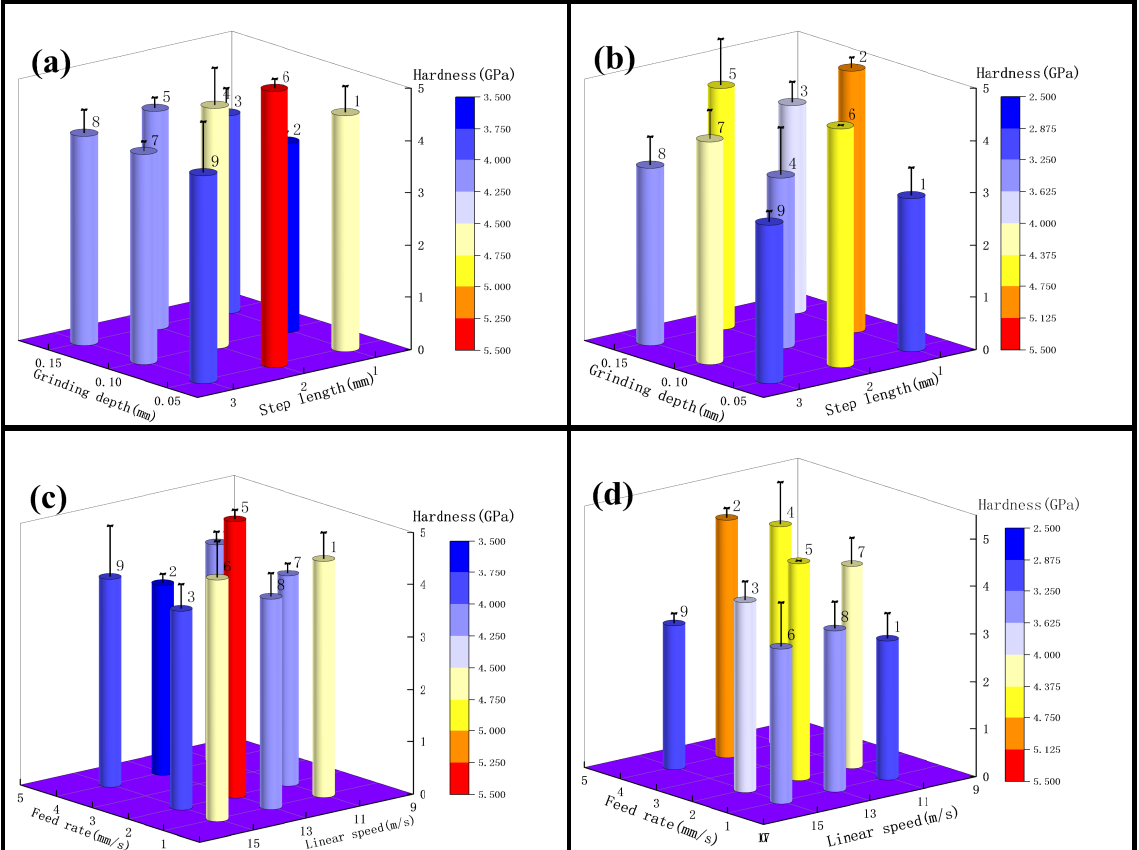
Figure 10. ( a ) for test 1, variables are grinding depth and step length; ( b ) for test 3, variables are grinding depth and step length; ( c ) for test 1, variables are linear speed and feed rate; ( d ) for test 3, variables linear speed and feed rate.